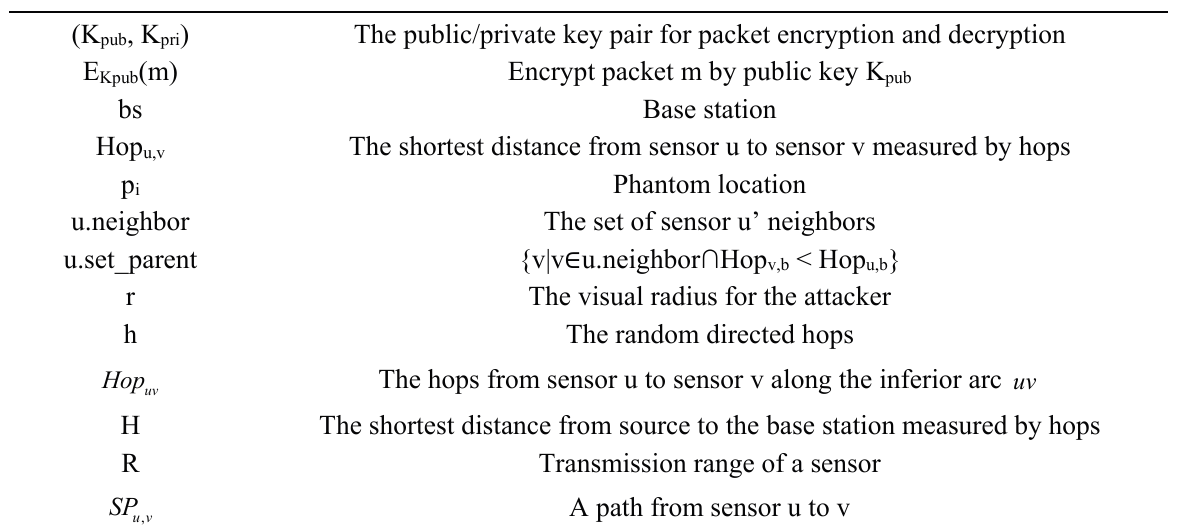
Table 1. Notations used in this